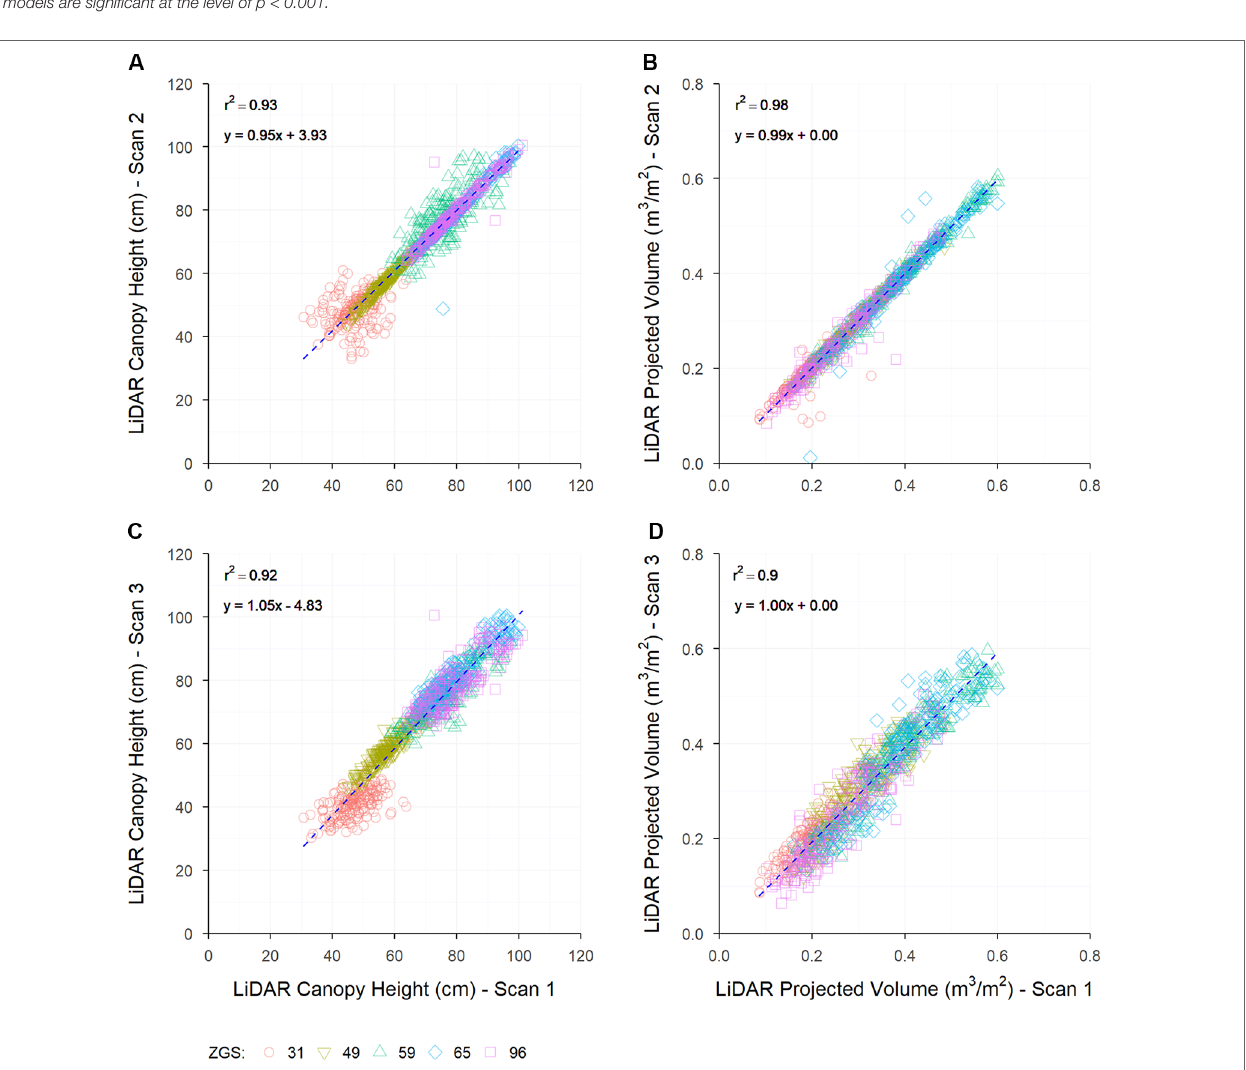
FIGURE 4 | The repeatability of LiDAR-based measurements collected at Roseworthy throughout the season, comparing scans collected from the same direction (A , B) and the opposite direction (C , D) for the measurement of LiDAR canopy height (A , C) and LiDAR projected volume (B , D) . Dashed lines indicate the line of best fit, coloured shapes indicate measurements collected at Zadoks growth scales (ZGS) as follows, red circles at ZGS 31, yellow triangles at ZGS 49, green triangles at ZGS 59, blue diamonds at ZGS 65 and pink squares at ZGS